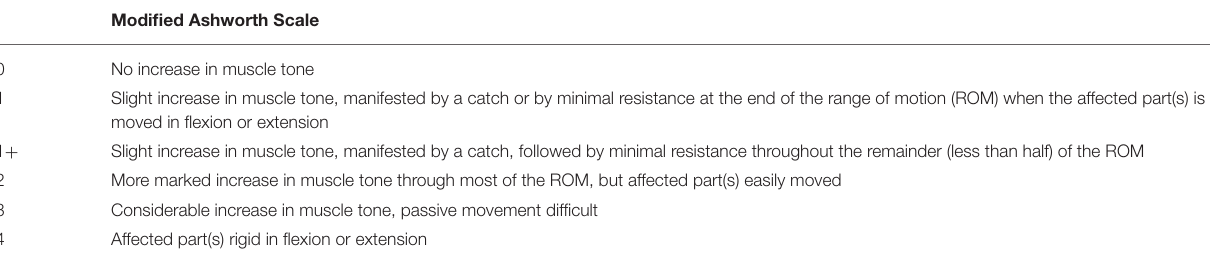
TABLE 3 | The modified Ashworth score (MAS)-specific scoring